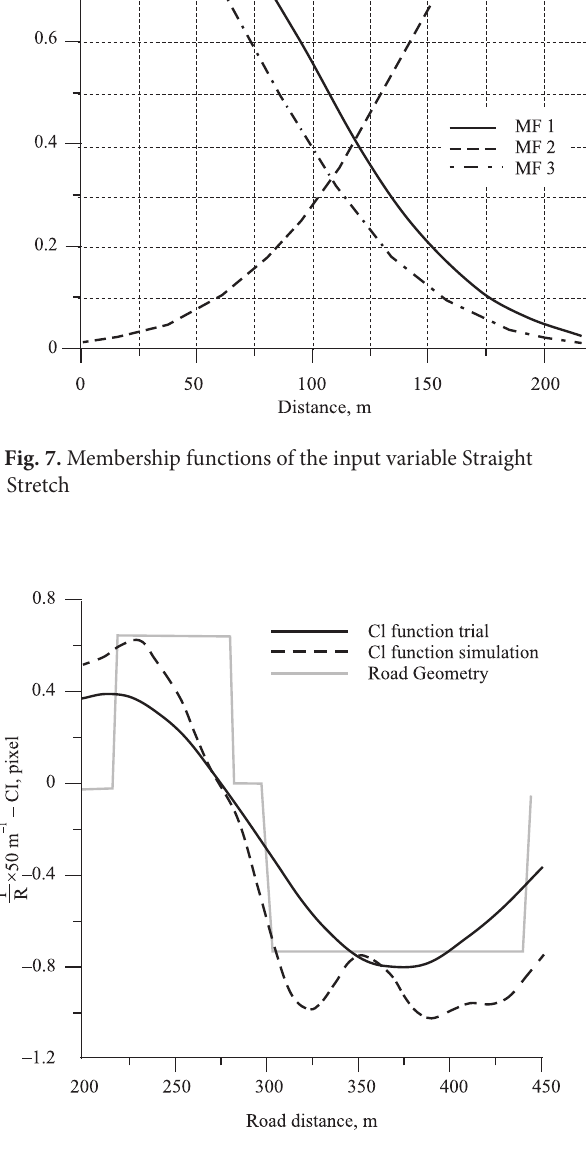
Fig. 8. Comparison of the CI function between the original and simulated scenarios in the section 200 – 450